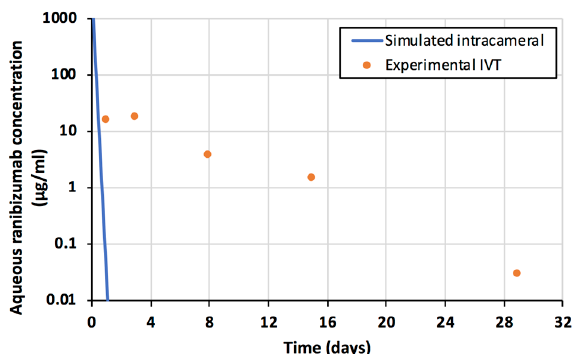
Figure 4. Ranibizumab concentrations in the aqueous humor after intravitreal injection (orange spheres). Simulated concentrations of ranibizumab after intracameral injection of the same dose (0.50 mg) are shown as blue line.